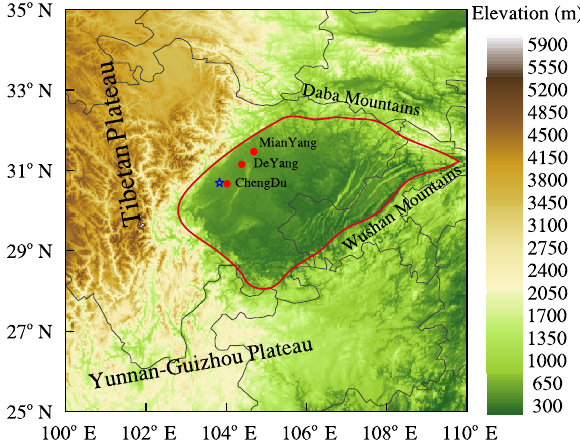
Figure 1. Topographic map (shading, units: m) of the Sichuan Basin (delineated in red) and surrounding areas showing the location of the cities of Chengdu, Deyang, and Mianyang (red dots). The Wen- jiang station is marked with blue five-pointed